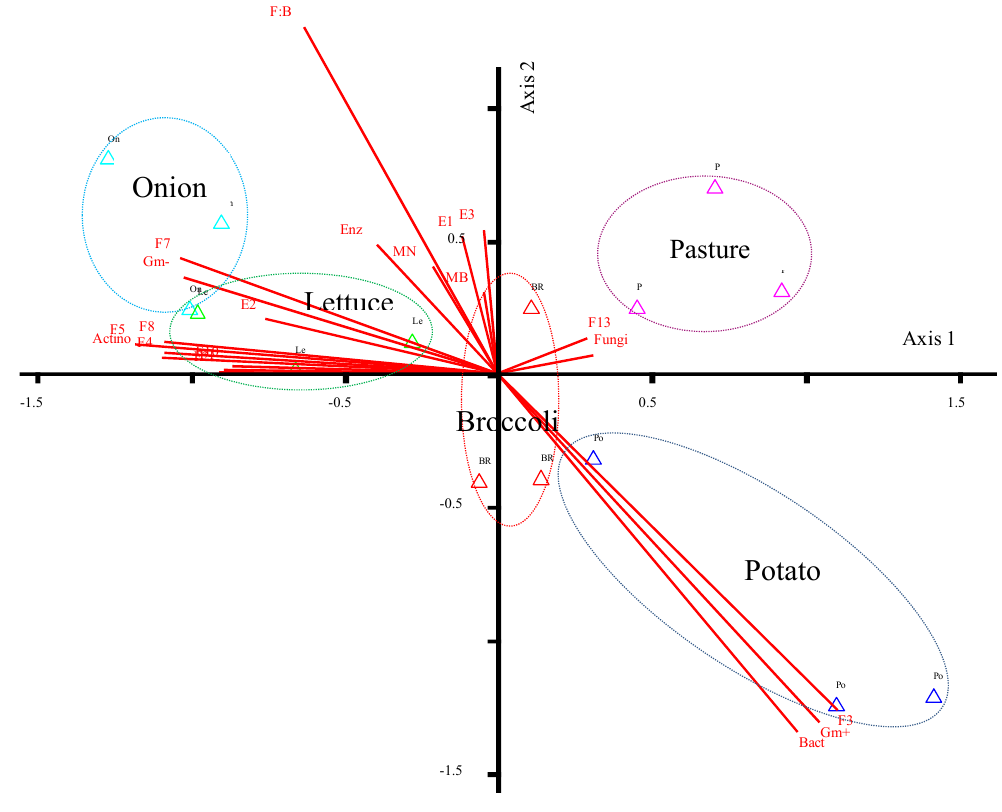
Figure 2. Non-metric multidimensional scaling (NMDS) plot of the relationship between soil microbial community composition (according to 13 FAMEs), enzyme activities and microbial biomass under different rhizospheres in an organic production system. The figure shows FAMEs for bacterial populations according to F1–5 for Gm+ (Gram+), F6–7 for Gm − (Gram − ) and F8–10 for actinomycetes (Actino) while the fungal populations are represented by F11–13. Fungal:bacterial ratios are shown as F:B. The enzyme activities are represented (Enz) with E labels such as E1 for arylsulfatase, E2 for β -glucosidase, E3 for β -glucosaminidase and E4 acid phosphatase. Microbial biomass is shown as MB (MC for microbial biomass C or MN for microbial biomass